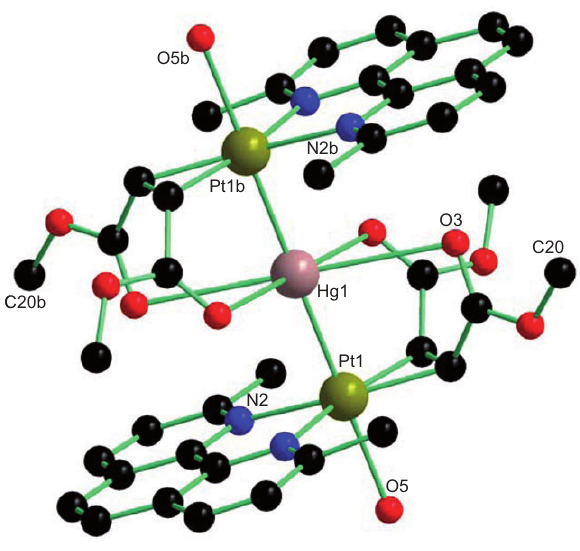
Figure 1 Structure of { [Pt(2,9-Me et al.,